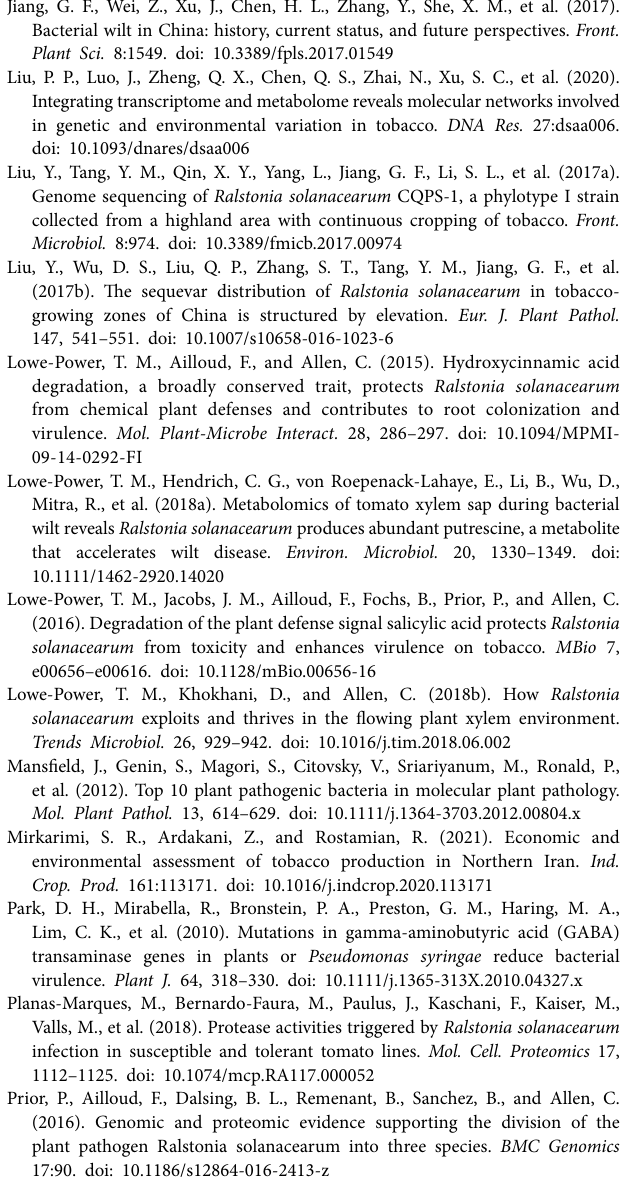
Supplementary Figure S2 | Different effect of tobacco metabolome of two tobacco cultivars in response to R. pseudosolanacearum infection. (A) PCA analysis of metabolite changes in infected and healthy tobacco plants. SI means susceptible tobacco cultivar infected with R. pseudosolanacearum , SNI indicates susceptible cultivar without pathogen infection. (B) The clustering tree of changed metabolites of tobacco Yunyan87 xylem sap under R. pseudosolanacearum infection. (C) PCA analysis of metabolites change of infected and healthy tobacco plants. RI means moderately resistant tobacco cultivar infected with R. pseudosolanacearum , RNI indicates moderately resistant cultivar without pathogen infection. (D) The clustering tree of changed metabolites in tobacco K326 xylem sap during R. pseudosolanacearum